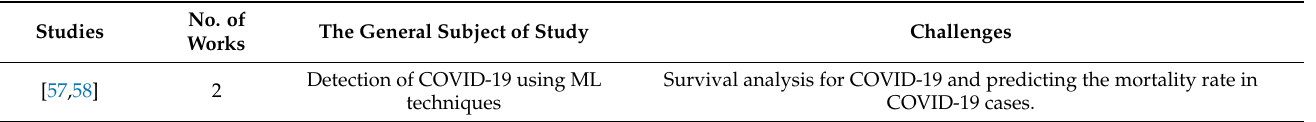
Table 3. List of studies selected for the systematic literature review organized by the general subject of